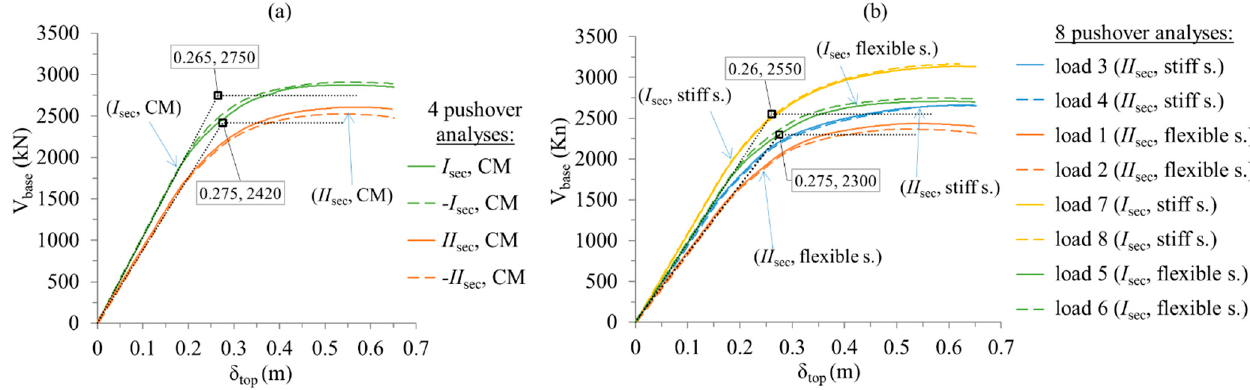
Figure 19. Capacity curves of the case 2 building resulted from: ( a ) N2 pushover procedure (EN 1998-1), ( b ) “inelastic dynamic eccentricities” pushover procedure. Load numbering is shown in Figure 7.